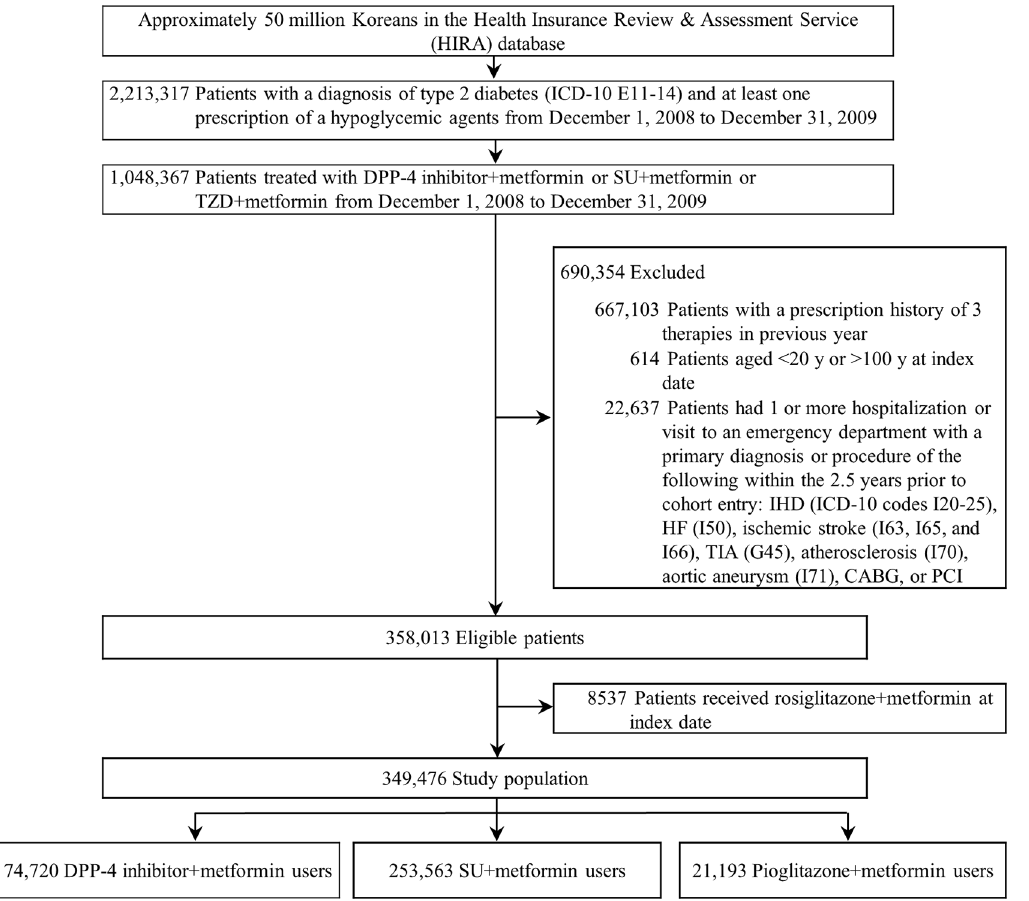
Fig 1. Selection of the study population. ICD-10 = the International Classification of Disease, Tenth Revision; SU = sulfonylurea; TZD = thiazolidinedione; DPP-4 = dipeptidyl peptidase-4; IHD = ischemic heart disease; HF = heart failure; TIA = transient ischemic attack; CABG = coronary artery bypass grafts; PCI = percutaneous coronary